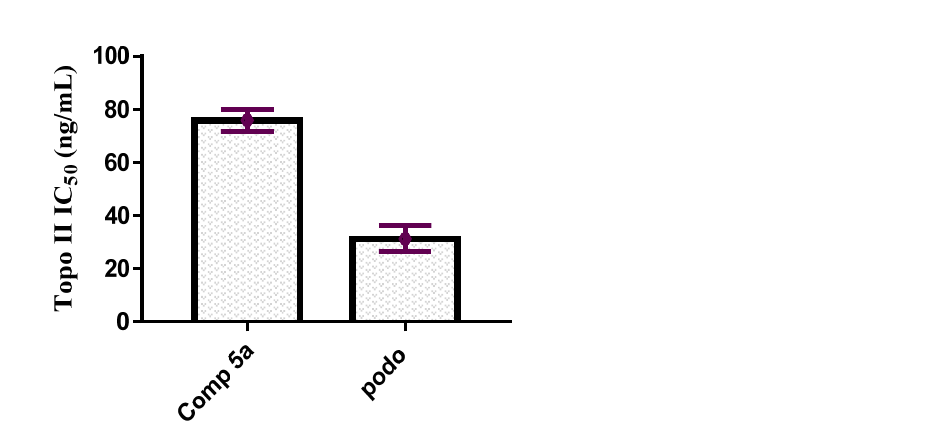
6 of 15 Figure 3. ( A ) Graphical representation of apoptosis effect of compound 5a on HCT-116 cell line. ( B ) Apoptosis effect of compound 5a on HCT-116 cell line. 2.2.4. Topoisomerase II Inhibitory Activity